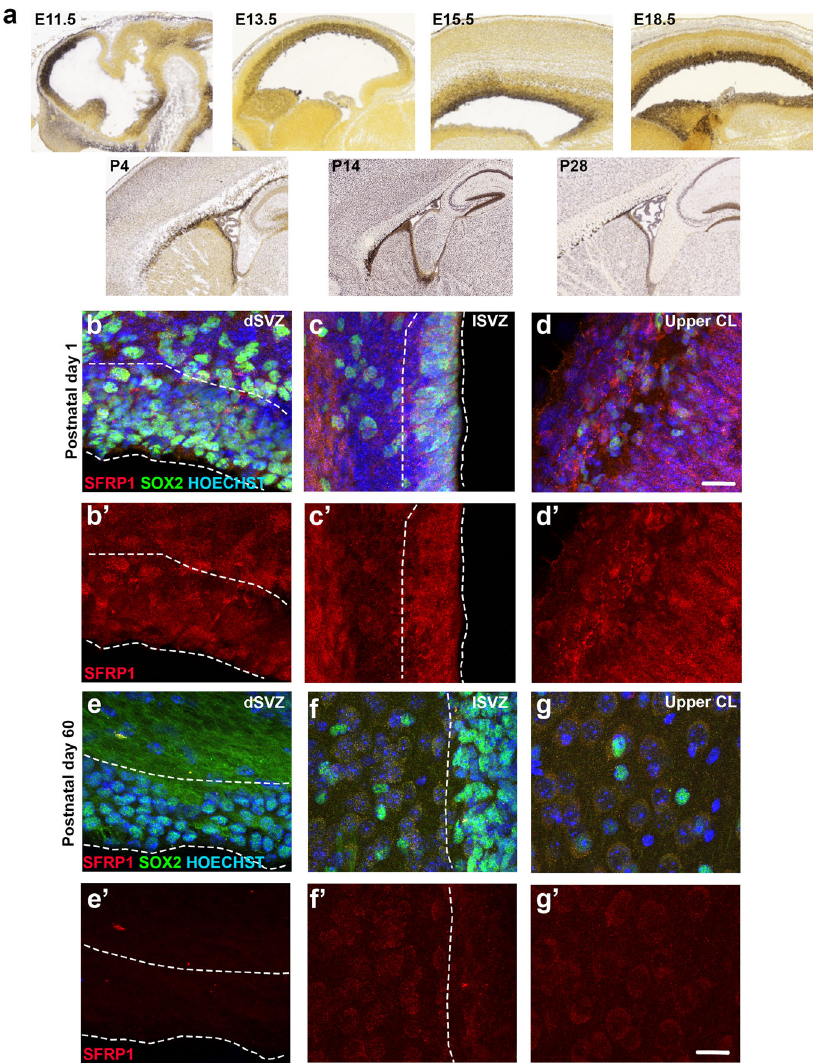
Fig. 6 SFRP1 is expressed in the neonatal and adult mouse brain. a In-situ hybridization images from the Allen Brain Atlas showing SFRP1 expression in the mouse brain at different developmental stages. b – d Representative images of SFRP1 expression in the mouse brain at postnatal day 1 ( n = 3 mice). Examples shown are from the dorsal SVZ ( b – b ′ ), lateral SVZ ( c – c ′ ), and cortical layers 1 – 2 ( d – d ′ ). e – g Representative images of SFRP1 expression in a 60 days old mouse brain ( n = 4 mice; 3 females and 1 male). Examples show dorsal SVZ ( e – e ′ ), lateral SVZ ( f – f ′ ) and upper cortical layer ( g – g ′ ).